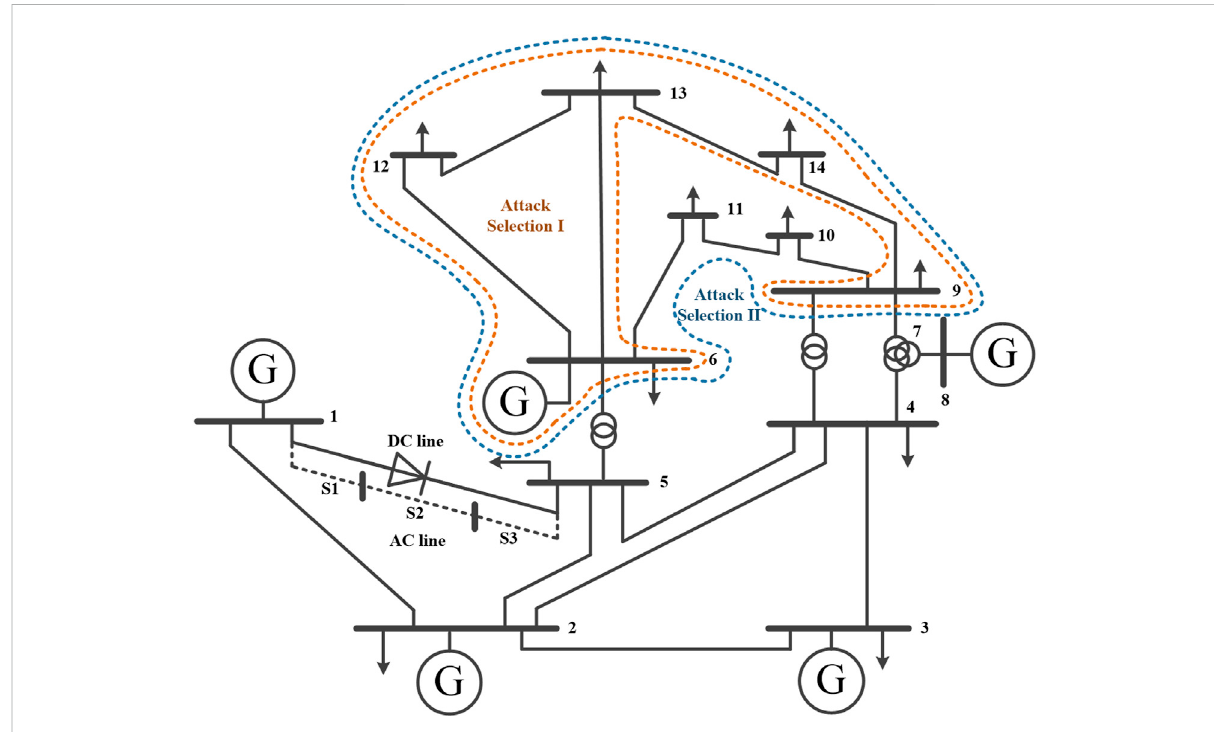
FIGURE 6 The modi fi ed IEEE14-node AC/DC hybrid transmission test